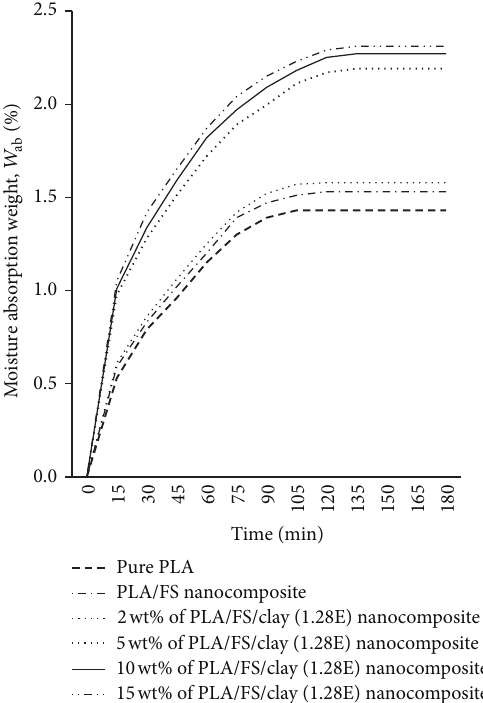
Figure 6: Moisture absorption curves of PLA/FS/clay (1.28E)